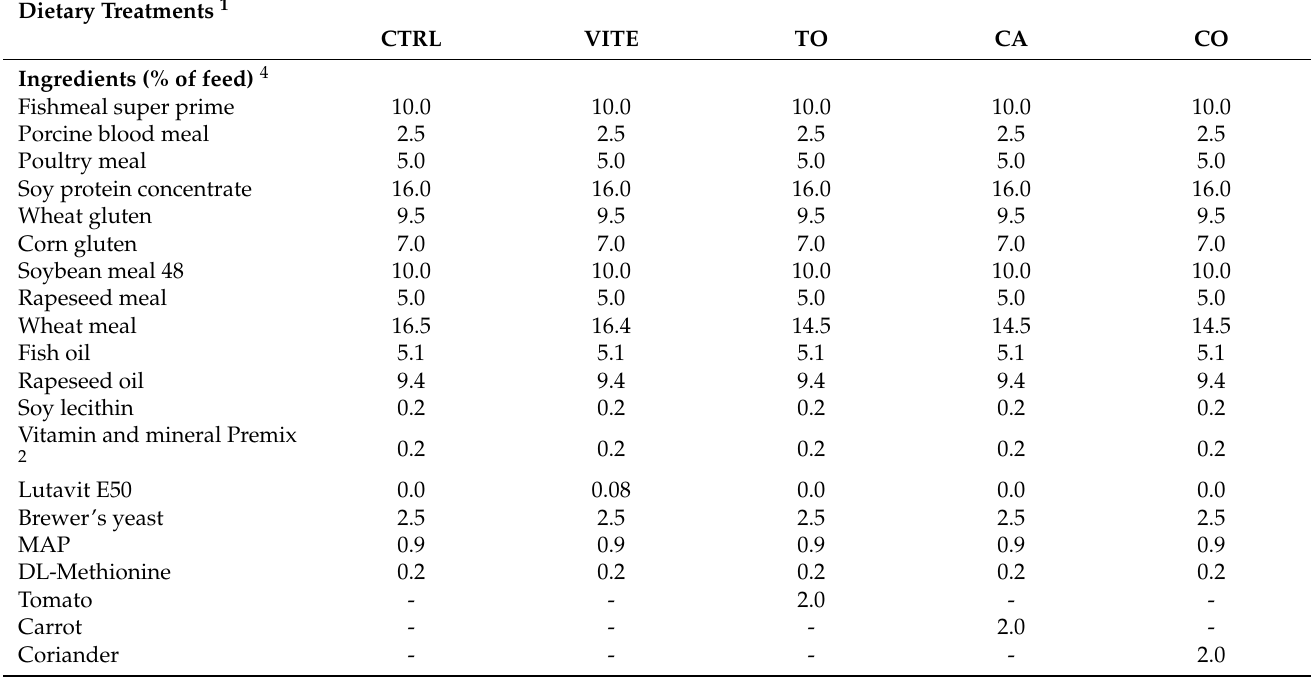
Table 2. Ingredients, proximate composition and antioxidant potential of the experimental